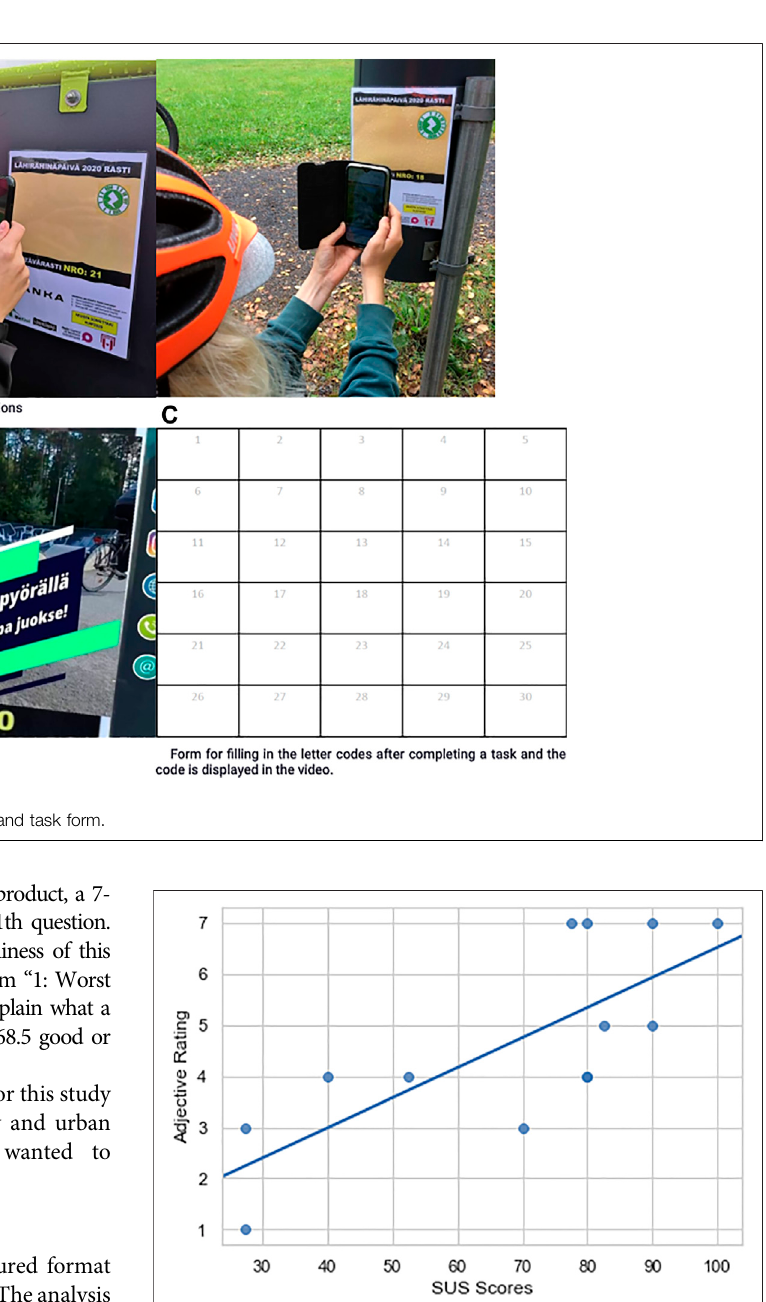
FIGURE4 | Correlationbetween SUSscore and adjective rating